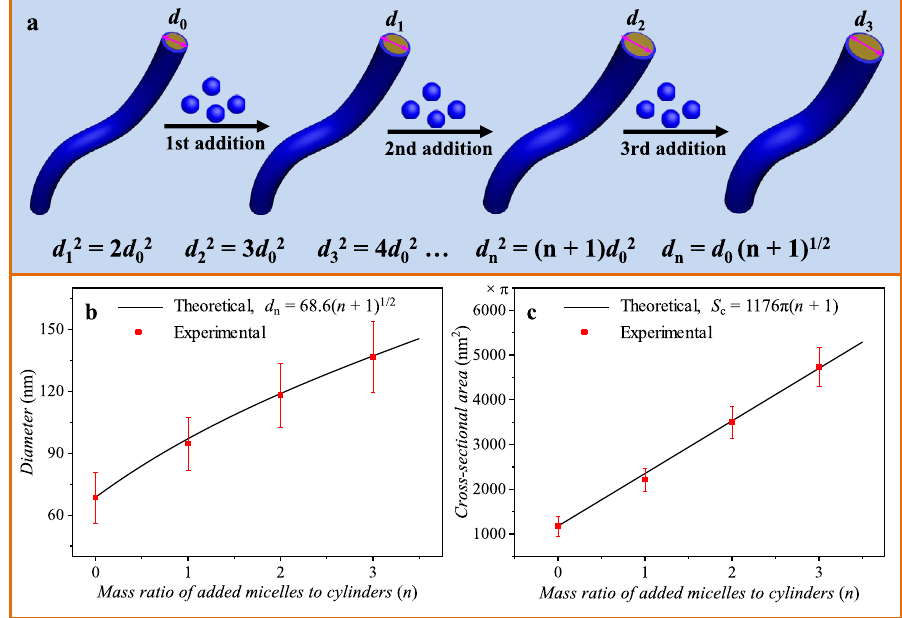
Fig. 5 Quantitative analysis of the living lateral growth of the cylinders. a Schematic illustration of the living lateral growth of cylinders, and the relationship between b diameter and c cross-sectional area of the cylinders and the mass ratio of added micelles to cylinders. The error bars in b and c are calculated by measuring the diameter of